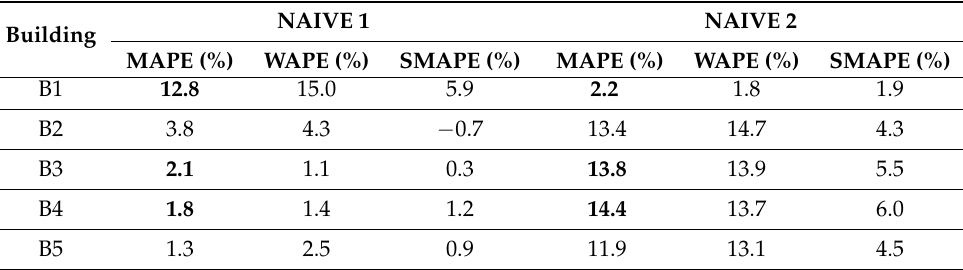
Table 9. Improvement in terms of prediction error reduction of the Artificial Neural Network model